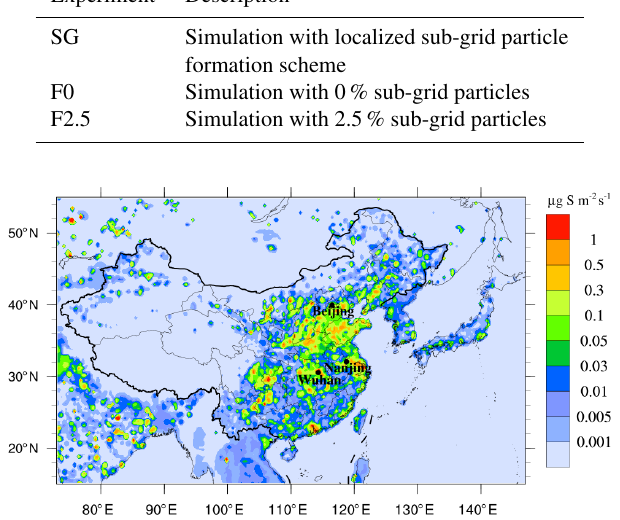
Figure 2. The nested domain with annual mean SO 2 emission flux (unit: µgSm − 2 s − 1 ) from energy and industry sectors in 2014. The black circles are locations of the observation